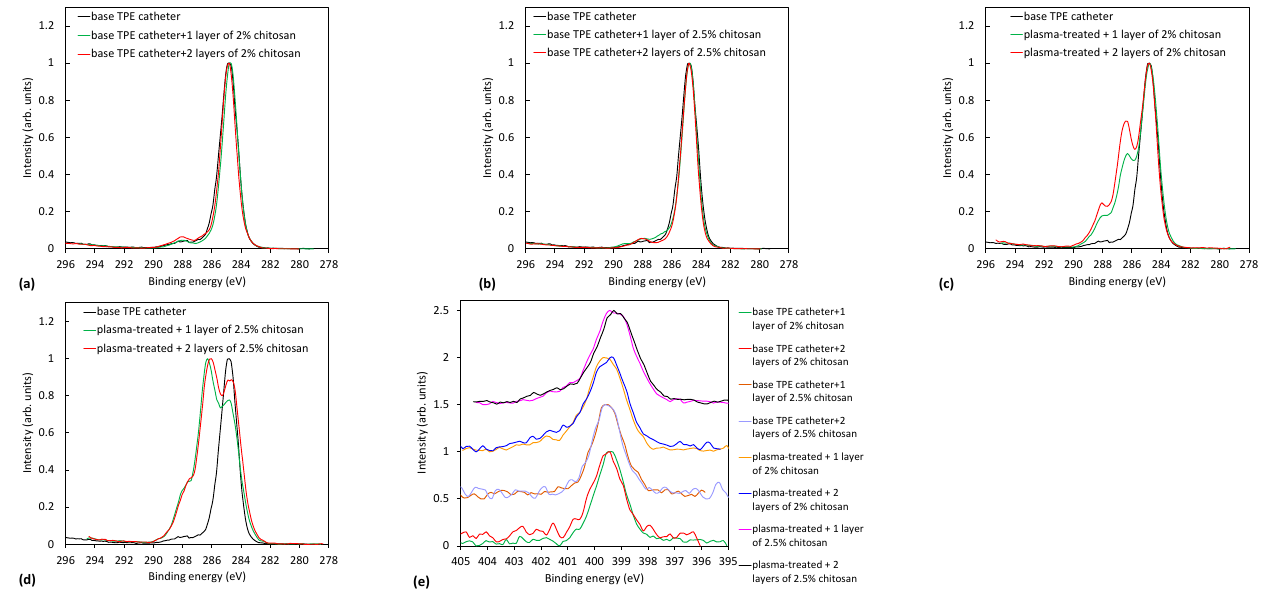
Figure 7. Comparison of XPS spectra of untreated and uncoated TPE catheters with coated catheters: ( a ) Soaking in 2% chitosan solution without plasma treatment; ( b ) Soaking in 2.5% wt. macromolecular chitosan solution without plasma treatment; ( c ) 2% chitosan coating with two-step plasma treatment; ( d ) 2.5% wt. macromolecular chitosan coating with two-step plasma treatment; and ( e ) comparison of nitrogen spectra for all coated TPE catheters.